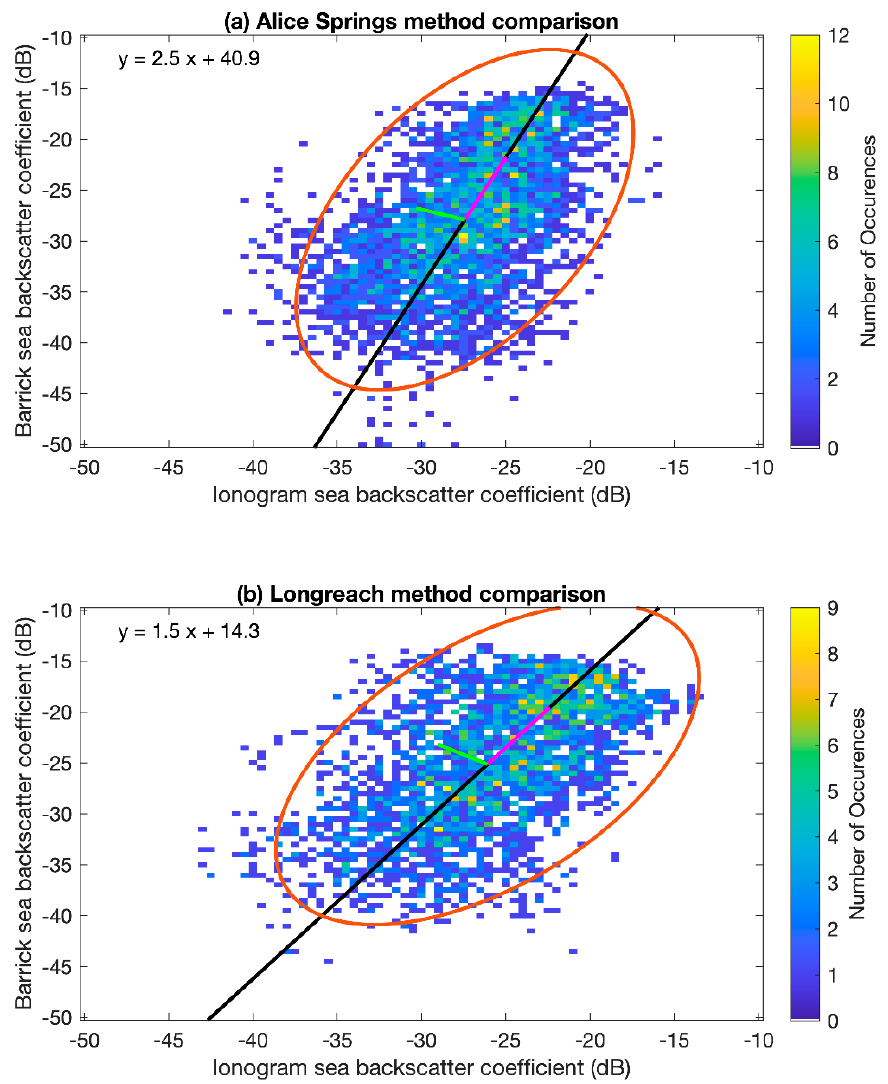
Figure 9. ( a ) Alice Springs and ( b ) Longreach sea surface backscatter coefficients from both September 2015 and March 2016 calculated using the Barrick method with hindcast data vs. sea surface backscatter coefficients calculated using the backscatter ionogram method. A line of best fit is shown in black, with the corresponding equation in the top left corner and a 95% confidence error ellipse shown in red. The eigenvectors of the covariance matrix are shown in green and magenta. The centre of the ellipse for Alice Springs is at ( − 27.4 dB, − 27.9 dB) and for Longreach is at ( − 26.1 dB, − 25.1 dB). Table 1. 95% confidence error ellipse results. The centre of the ellipse is at (X0, Y0). Covariance Sounder Matrix